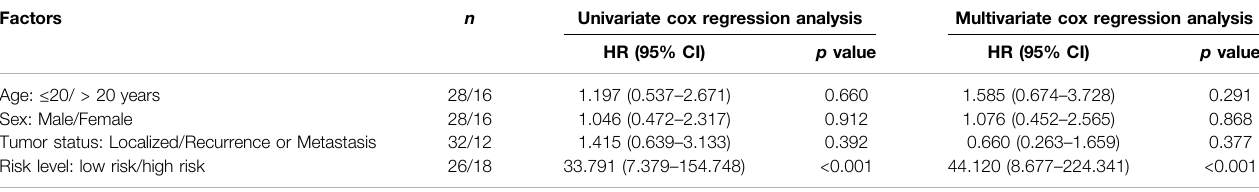
TABLE 2 | Univariate and multivariate cox regression analysis of clinical information for EWS patients in the training cohort.